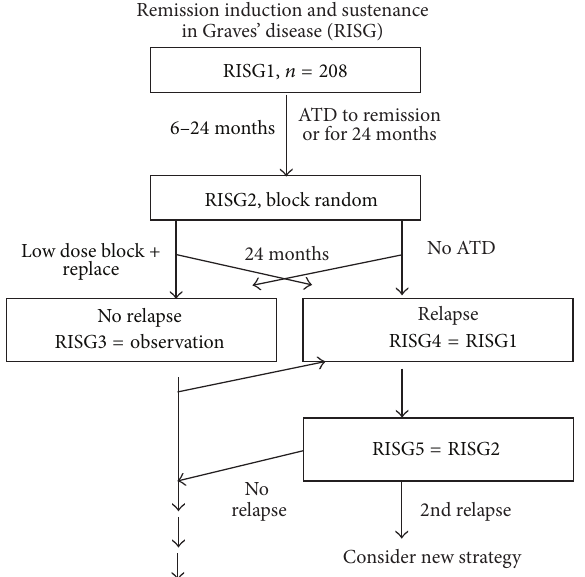
Figure 1: Overview of the RISG study. The present study describes the 208 patients